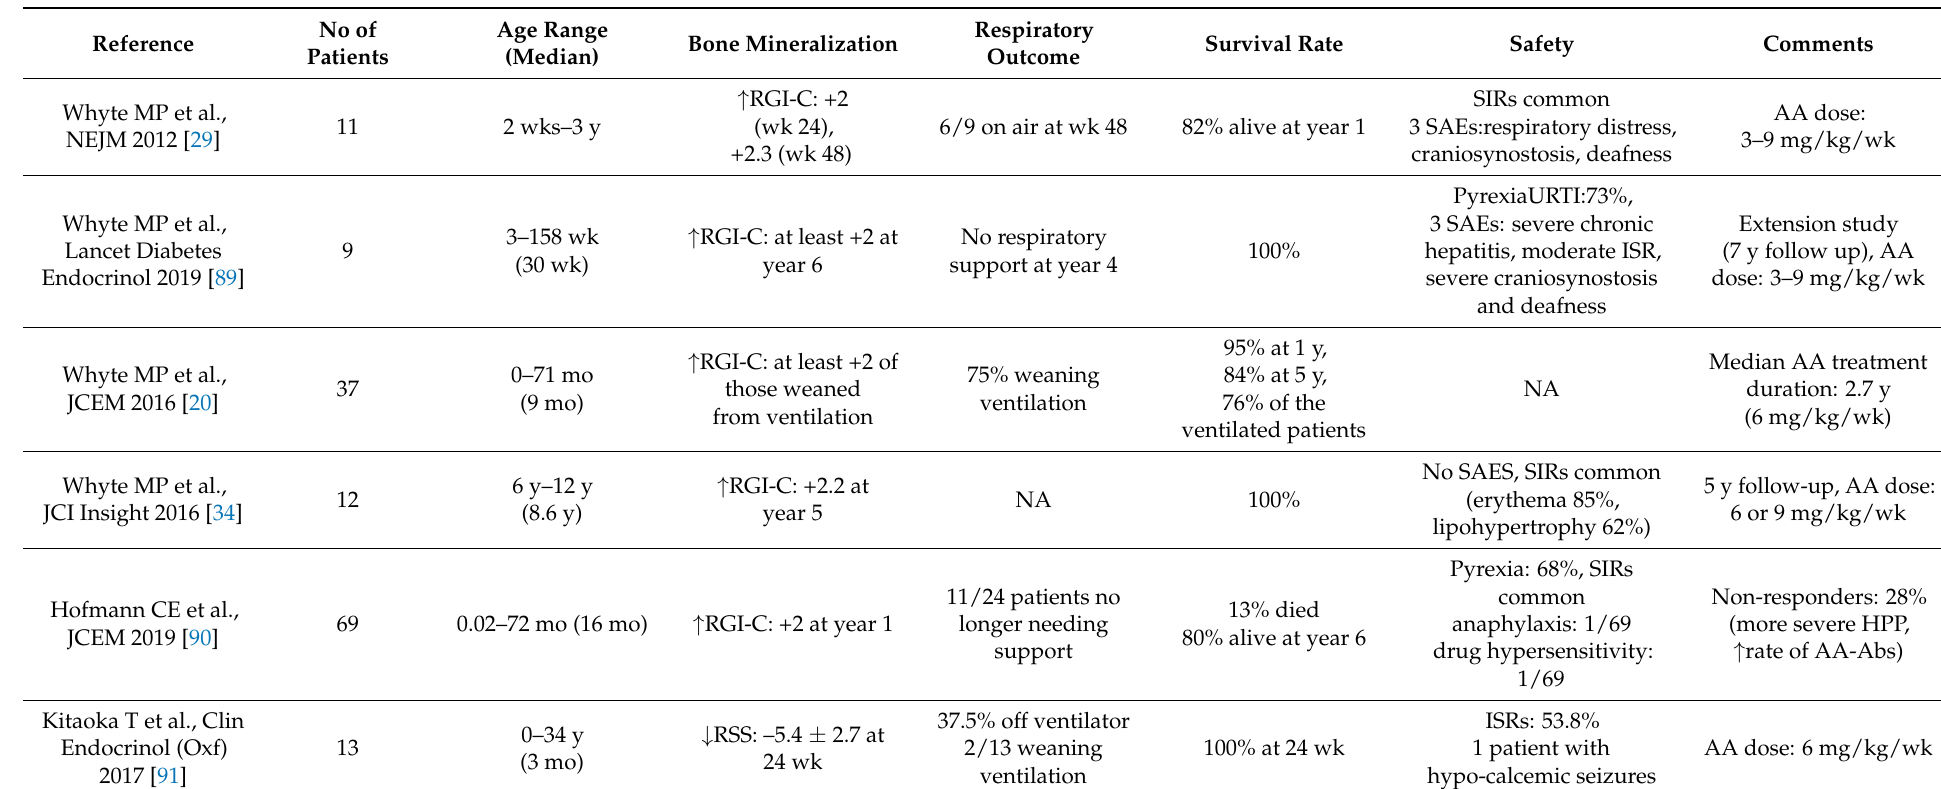
Table 2. Clinical studies of asfotase-alfa in paediatric